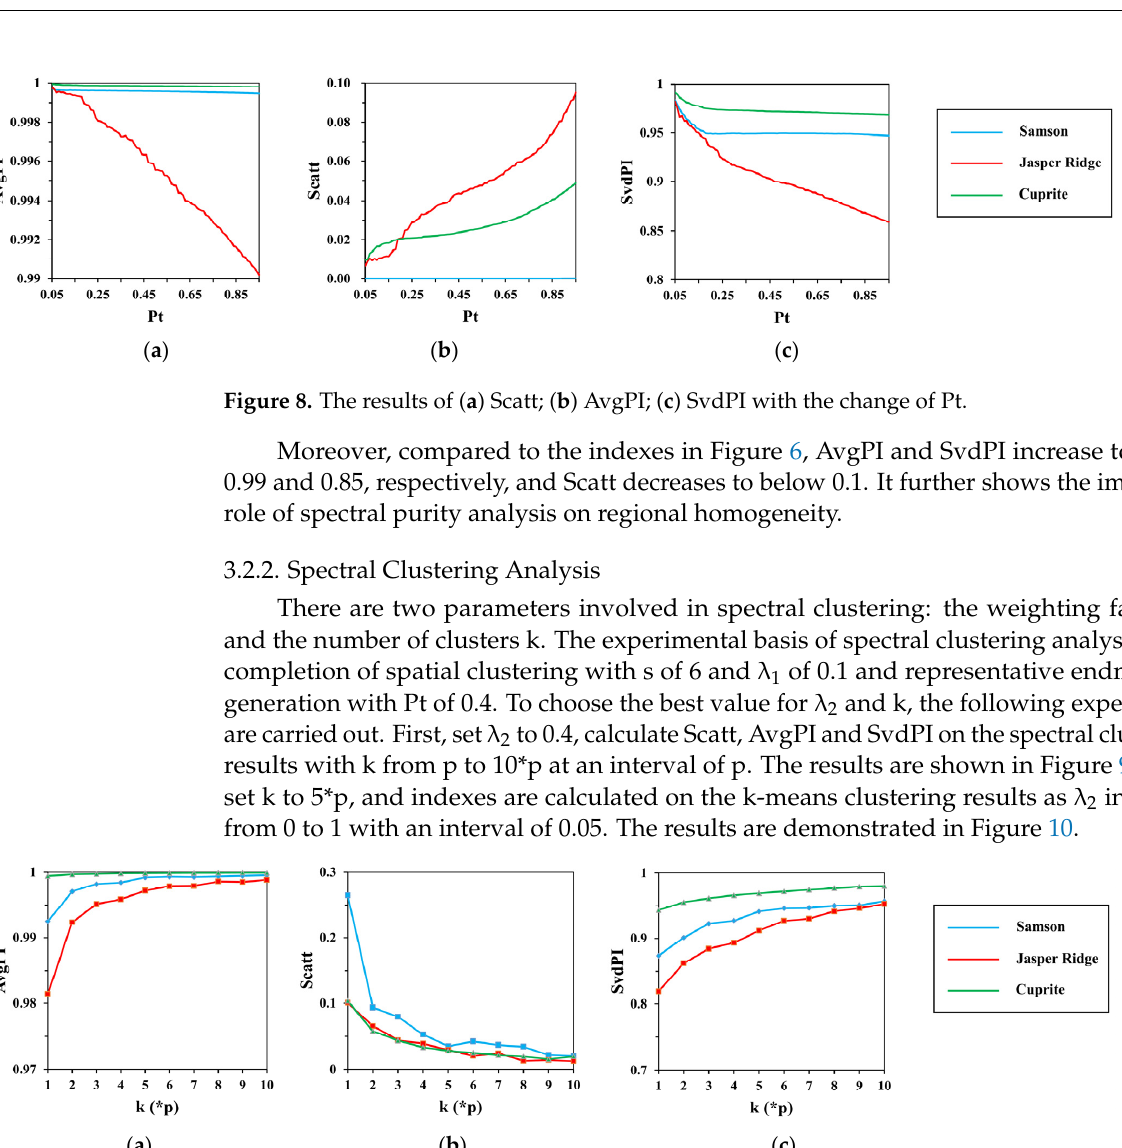
Figure 7. The results of spatial clustering. ( a ) Samson; ( b ) Jasper Ridge; ( c ) Cuprite.